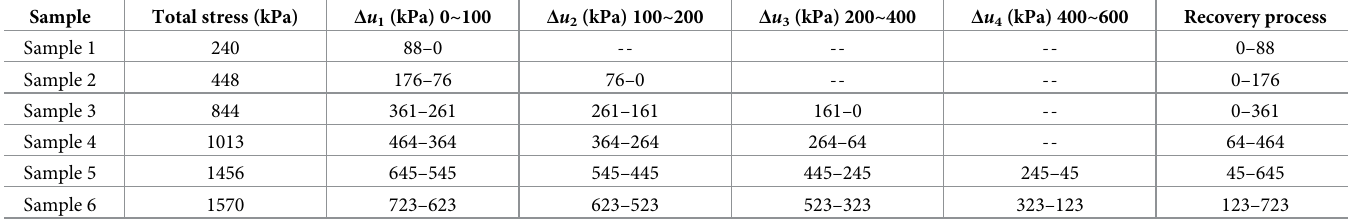
Table 3. Test design for groundwater withdrawal and recharge for each soil sample.